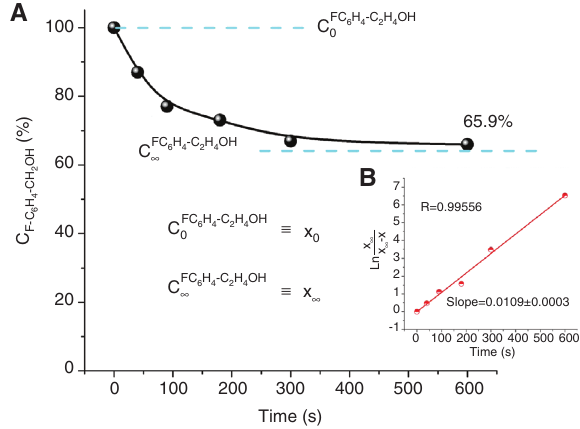
Figure 6 Kinetic studies for the evolution of the concentration of reagent with time in the microwave-assisted selective oxidation of 4-fluorobenzyl alcohol using hydrogen